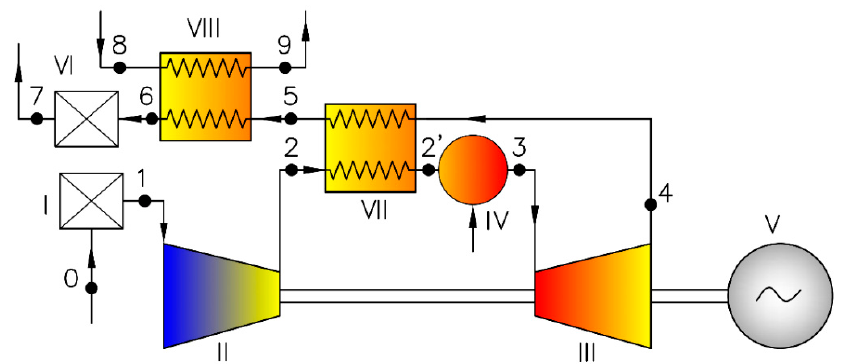
Figure 13. Circulation diagram with a gas turbine with a regenerator and cogeneration (Variant 3-V3). I–filter; II–compressor; III–turbine; IV–combustion chamber; V–electric generator; VI–silencer; VII–regenerator; VIII- heat exchanger (for cogeneration heat).